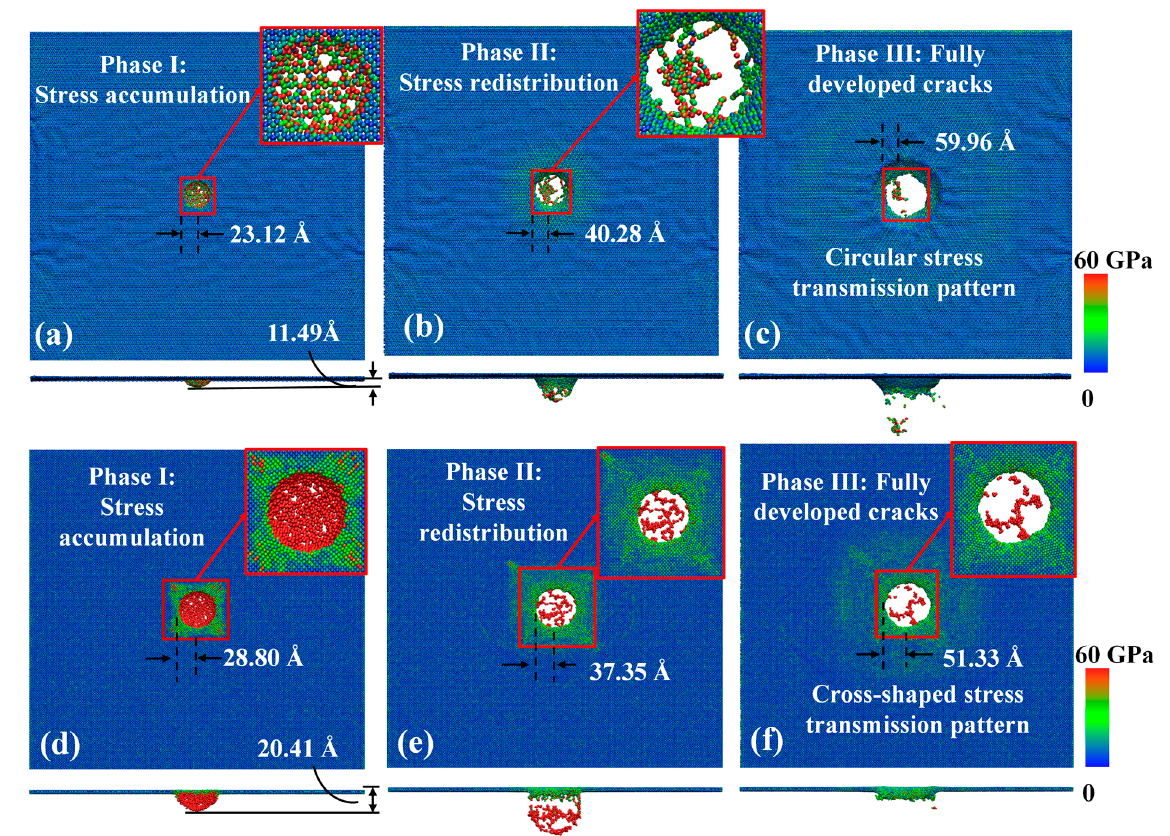
Figure 2. Von Mises stress distribution of nanosheets under impact velocity of 3km/s. ( a – c ) Atomic configuration of Ti 8 C 5 : ( a ) Von Mises stress distribution pattern at a simulation time of 1.3 ps; the insert represents stress accumulation and formation of cracks in the impact region; ( b ) Stress redistribution/propagation at a simulation time of 2.3 ps; ( c ) Final atomic configuration at 4.0 ps. ( d – f ) Atomic configuration of copper: ( d ) Von Mises stress distribution pattern at a simulation time of 2.0 ps; ( e ) Stress propagation phase at 3.0 ps; ( f ) final atomic configuration at 6.0 ps.